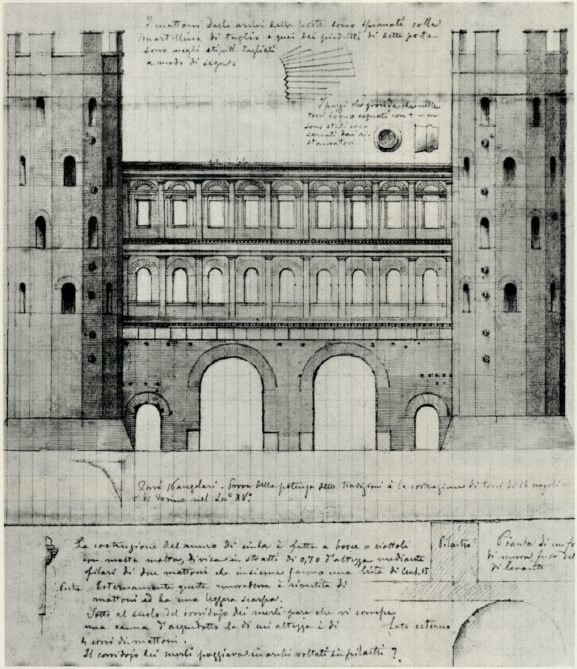
Figure 4 . Alfredo d’Andrade, Survey of the gate, 1883. © Fondazione Torino Musei, Fondo d'Andrade.